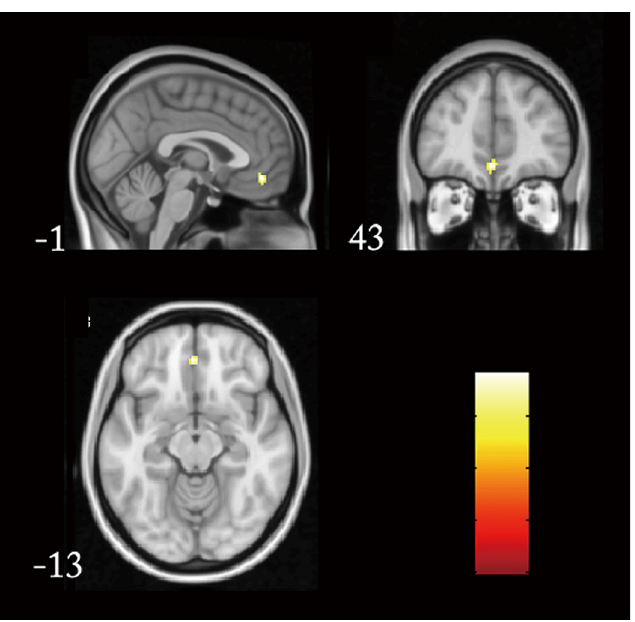
Fig 3. Whole brain functional connectivity by taking LPHC as a seed region. Significantly increased functional connectivity presented in medial prefrontal cortex (cluster size = 20, p = 0.005) in APOE ε 4 carriers were presented from different